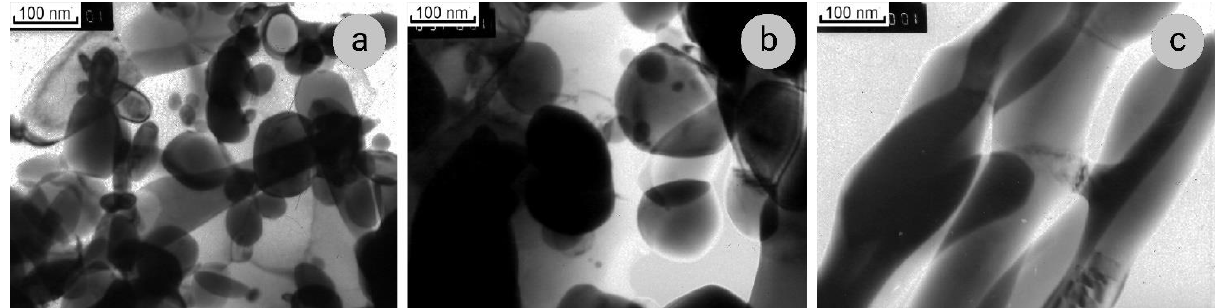
Figure 9. The structure of Sample 2 ( e = 12,5) after annealing at 700 ° С, 1 h ( a ) and 800 ° С, 1 h ( b , c ): ( a , b ) — transverse sections, ( с ) — longitudinal section.